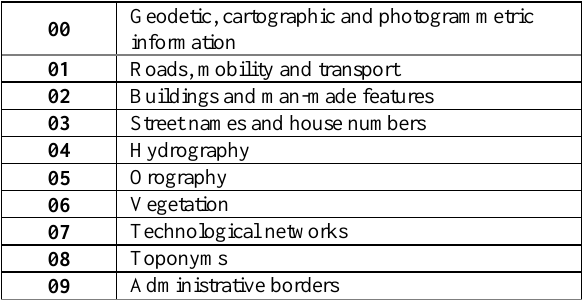
Table 1. The first level of the map tree-structured classification Once chosen the ‘02’ branch, five further classes are planned, which are listed in Table 2. Finally, five more options are available for the ‘0201’ branch, which are listed in Table 3.